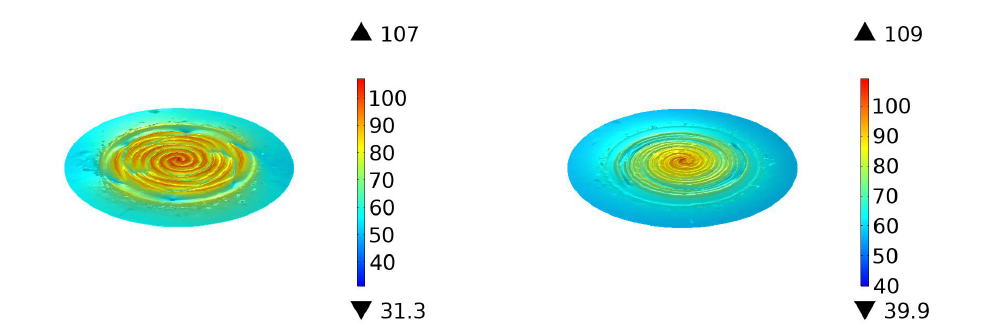
Figure 8. Electric field distribution of the slot-spiral structure ( left ) and spiral structure ( right ) at n = 7, w = g = 15 µ m, and 300